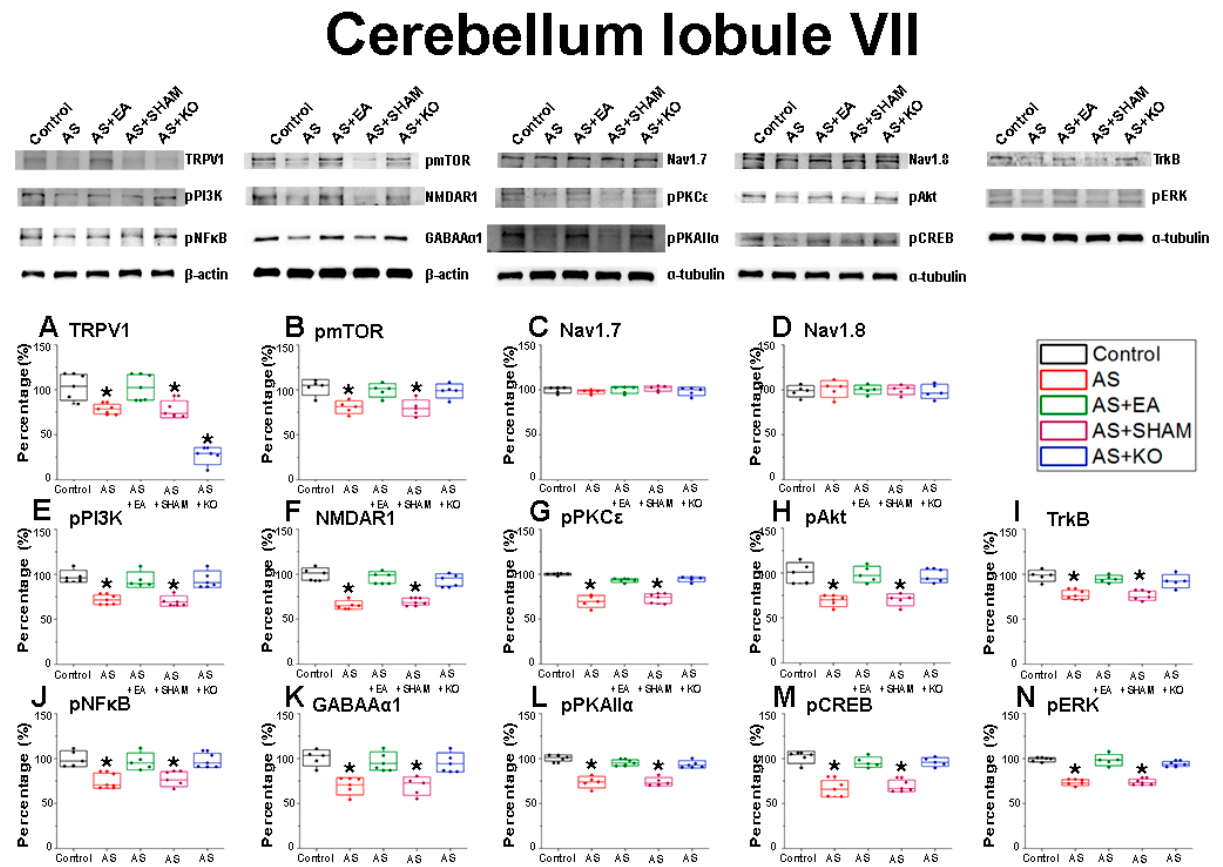
Figure 3. The expression levels of nociceptive receptors and associated molecules in the cerebellum lobule VII. The immunoblotting images depict five lanes of protein in the following order: Control, AS, AS + EA, AS + SHAM, and AS + KO groups. There are significant decreases in protein expression in the AS and AS + SHAM groups of ( A ) TRPV1, ( B ) pmTOR, ( E ) pPI3K, ( F ) NMDAR1, ( G ) pPKC ε , ( H ) pAkt, ( I ) TrkB and ( J ) pNF κ B ( K ) GABAA α 1, ( L ) pPKAII α , ( M ) pCREB, and ( N ) pERK levels, which were significantly attenuated in the AS + EA and AS + KO groups, depicting no difference when compared to the Control group. Interestingly, the protein expression levels of ( C ) Nav1.7 and ( D ) Nav1.8 displayed states of no significant variances across all 5 groups. Accordingly, the protein density of the AS + KO group revealed a predicted decrease in ( A ) TRPV1 (* p < 0.05).